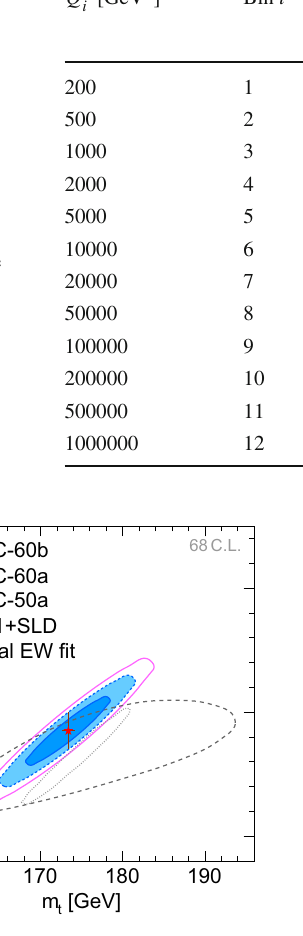
Fig. 8 Simultaneous determination of the W -boson and top-quark masses from LHeC-60a or LHeC-50a data. Results from the Z -pole fit using LEP+SLD data [62] and from a global EW fit, where direct measurements of m W and m t have been excluded [66] are also